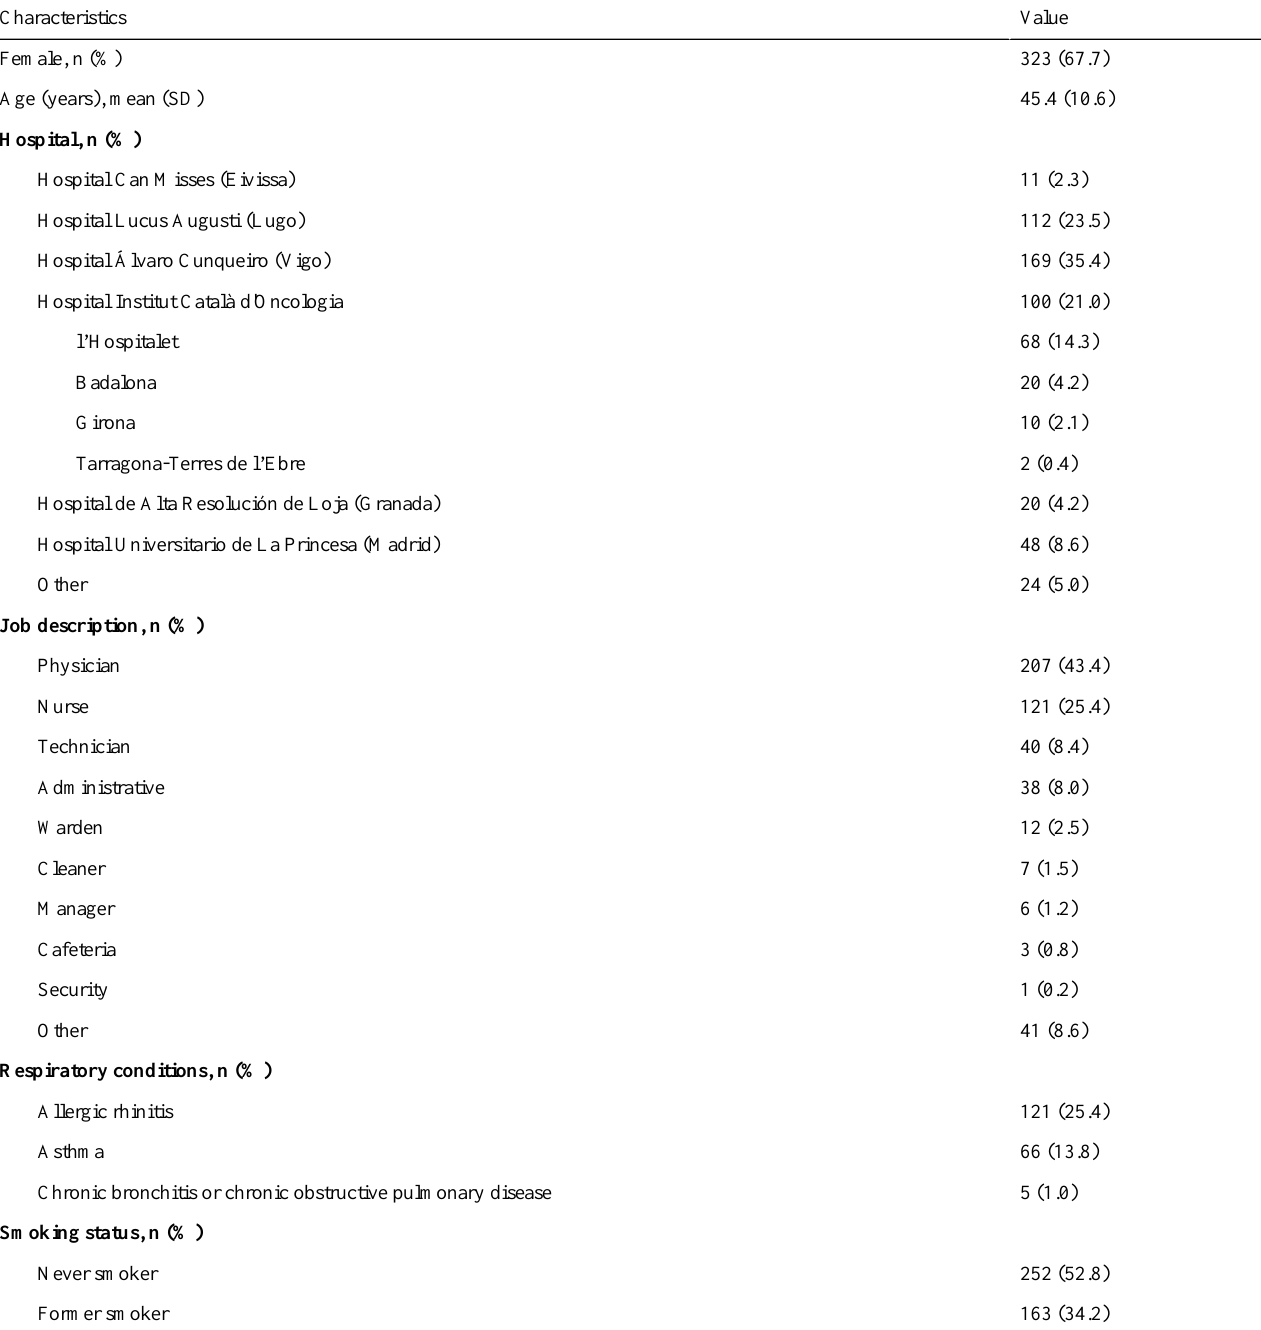
Table 2. Demographic and clinical characteristics of 477 HEpiTracker